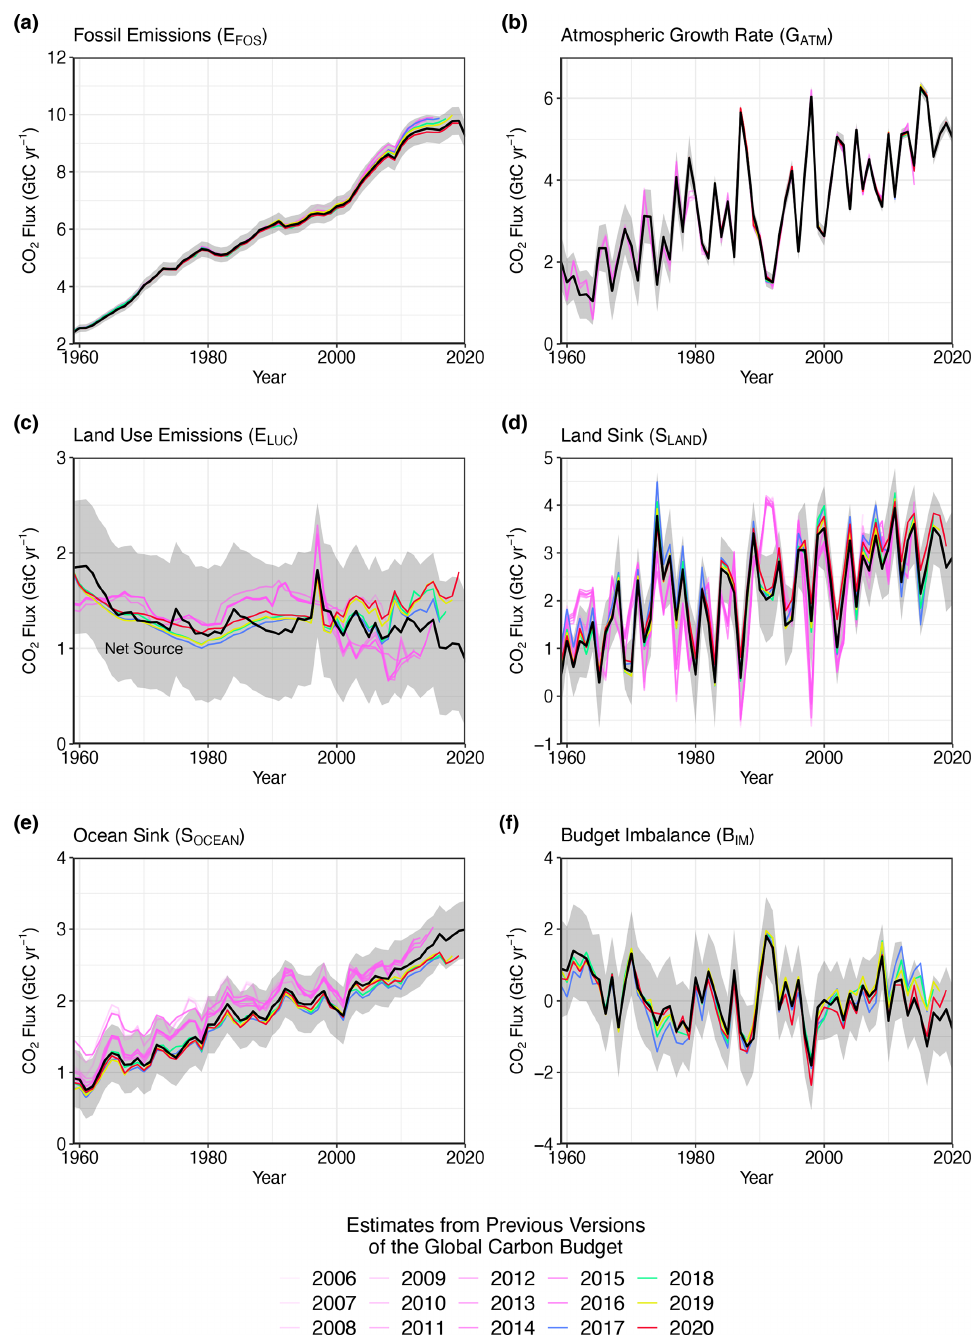
Figure B5. Comparison of the estimates of each component of the global carbon budget in this study (black line) with the estimates released annually by the GCP since 2006. Grey shading shows the uncertainty bounds representing ± 1 standard deviation of the current global carbon budget, based on the uncertainty assessments described in Appendix C. CO 2 emissions from (a) fossil CO 2 emissions ( E FOS ) and (b) land- use change ( E LUC ), as well as their partitioning among (c) the atmosphere ( G ATM ), (d) the land ( S LAND ), and (e) the ocean ( S OCEAN ). See legend for the corresponding years, and Tables 3 and A7 for references. The budget year corresponds to the year when the budget was first released. All values are in GtCyr − 1